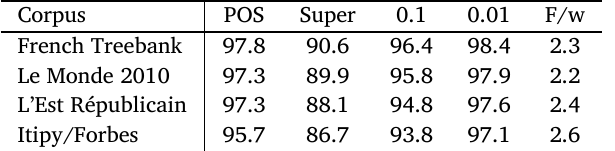
Corpus POS Super French